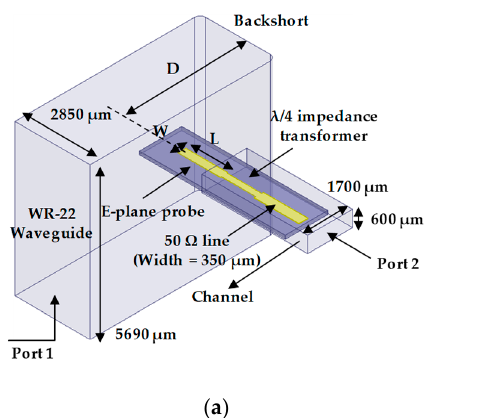
Figure 7. Waveguide-to-microstrip transition using E-plane probe. ( a ) Q-band transition. ( b ) D-band transition.